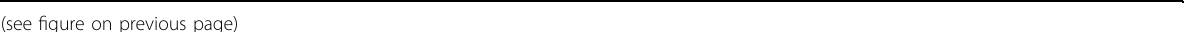
Fig. 6 Effects of chemotherapy on ACBP/DBI levels in breast cancer patients. Chemotherapy does not induce any change in BMI ( A ), but induces a decrease of ACBP/DBI ( B ), as well as a loss of the correlation between ACBP/DBI and BMI ( C ). ACBP/DBI better correlates with BMI after chemotherapy compared to before chemotherapy ( D ) and patients whose weight increased during chemotherapy tend to have higher DBI levels ( E ). Box and whisker plots representing BMI (kg/m 2 ) ( A ) and ACBP/DBI levels (ng/mL) ( B ) before and after chemotherapy in the CANTO cohort. Scatter plots with regression lines between ACBP/DBI (ng/mL) and body mass index (kg/m 2 ) are shown before and after chemotherapy for the CANTO cohort ( C ). Pearson ’ s correlation coef fi cient (R) and their p value and number of samples available ( n ) are shown in the legend of each